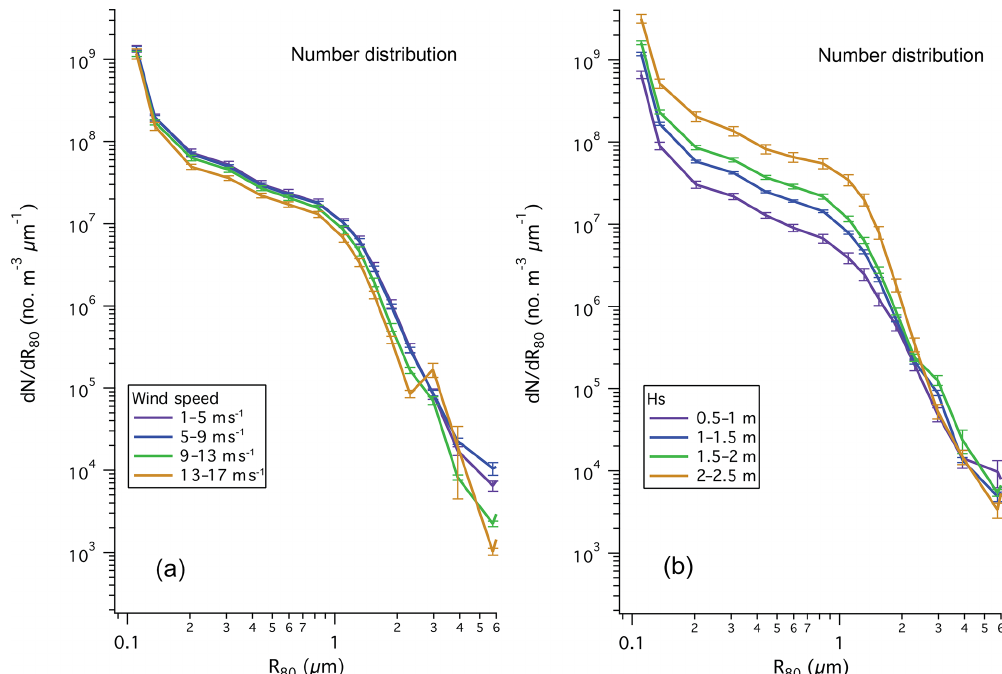
Figure 10. Size-distributed aerosol number from the CLASP, bin-averaged according to wind speed (a) and significant wave height (b) . Data are limited to the southwest (open water) wind sector only. Error bars indicate standard errors. Radius adjusted from ambient humidity to a relative humidity of 80%.